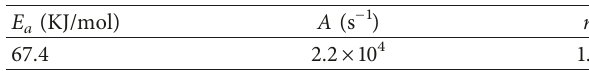
Table 2: Epoxy resin kinetic